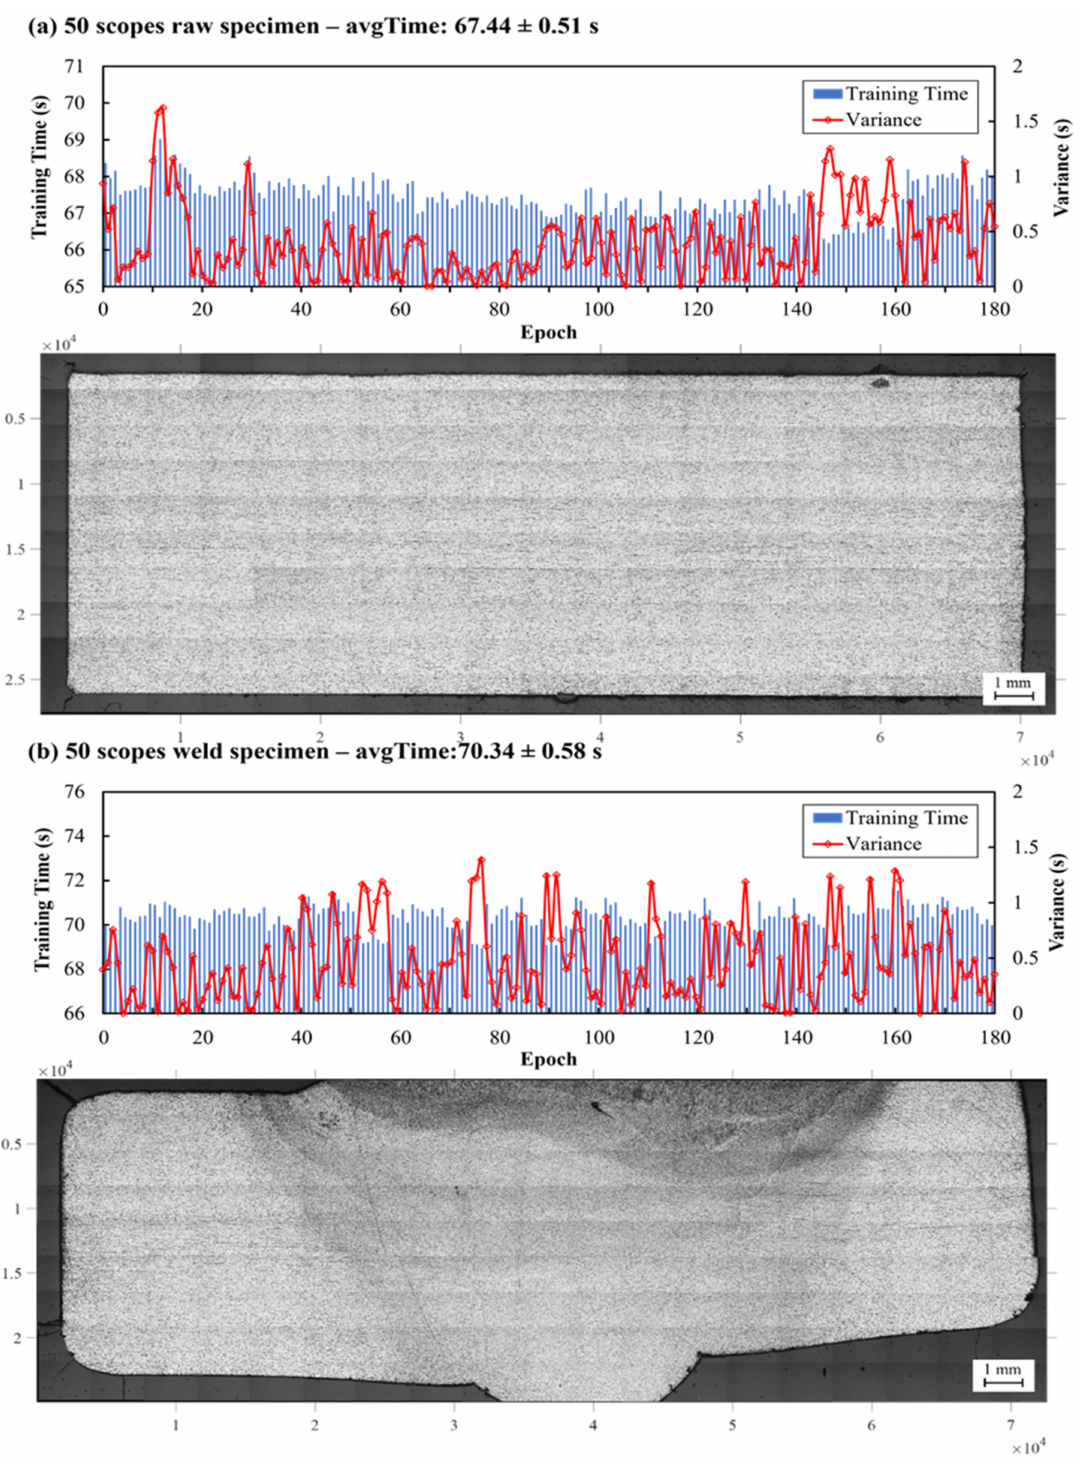
Figure 9. The final results of the 50-scope stitched image and analysis of training time: ( a ) raw and ( b ) weld